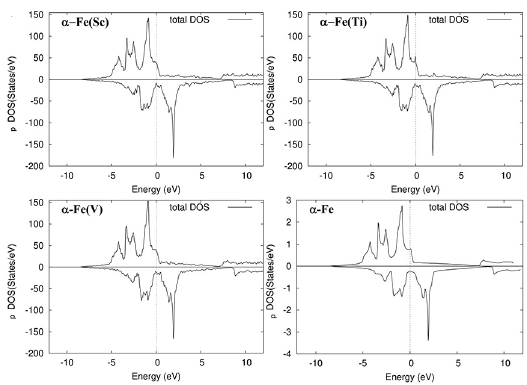
Figure 3. Calculated partial density of states (pDOS) of the TM (Sc, Ti, and V) impurities in α-Fe. The vertical line at zero energy represents the Fermi energy.